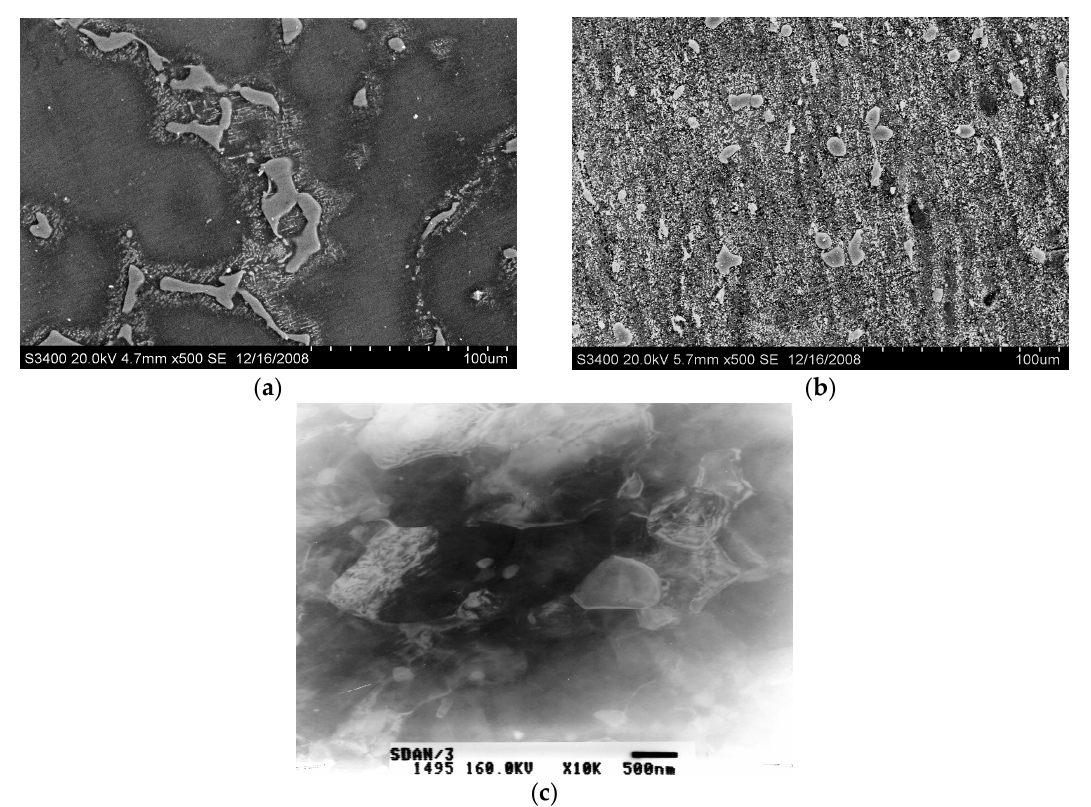
Figure 3. UFG (ultrafine-grained) grains of α -Mg phase and the highly refined secondary phase. ( a ) SEM image of as-cast AZ91; ( b ) SEM image of AZ91 after 12 ECAP passes; ( c ) TEM images of AZ91 after 12 ECAP passes Reproduced with permission from [18], Elsevier, 2011.